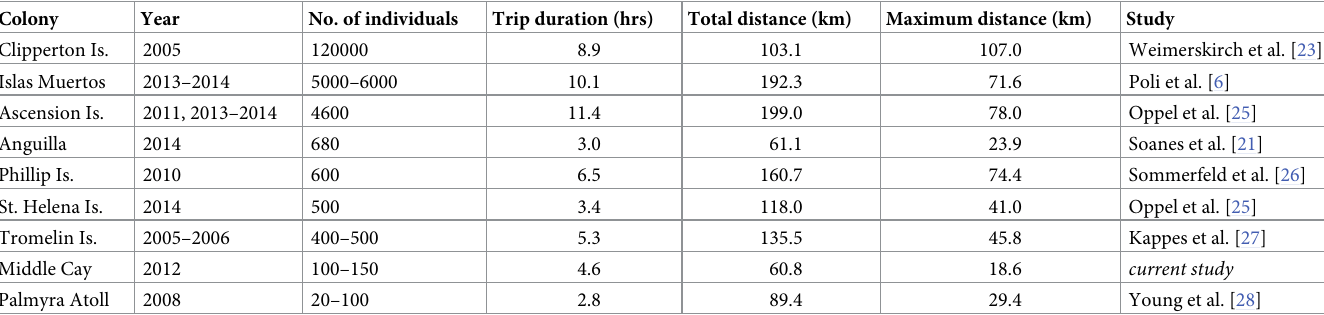
Table 1. Average foraging metrics of Masked Boobies acquired via literature search used in a hierarchical clustering analysis.